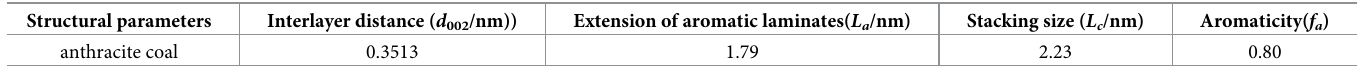
Table 3. XRD structural parameters of anthracite